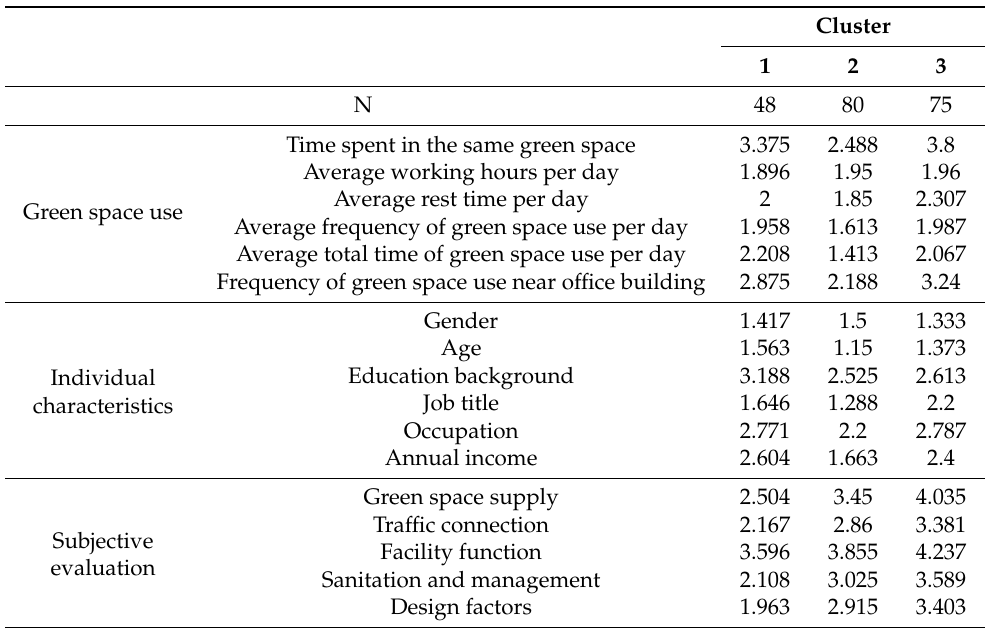
Table 5. Final cluster centers (three clusters).